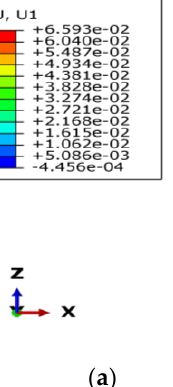
( b ) Figure 9. The lateral deformation along the conductor axial direction, where ( a ) is the result calcu- lated by the contact surface model and ( b ) is that calculated by the Goodman contact element model. ( a )